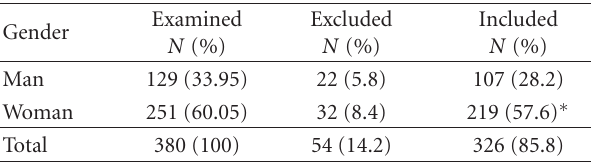
Table 1: Distribution of the subjects in the